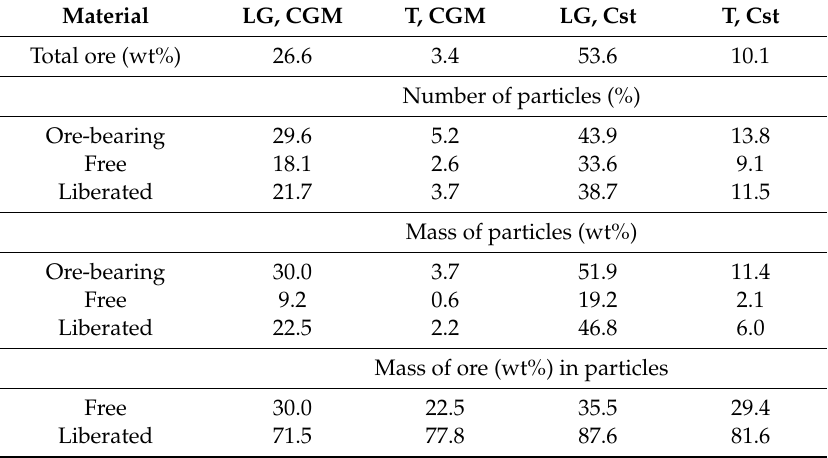
Table 6. Classification of ore-bearing particles from concentrates of Penouta outcropping leucogranite (LG) and tailings (T) determined by MLA. Cst,